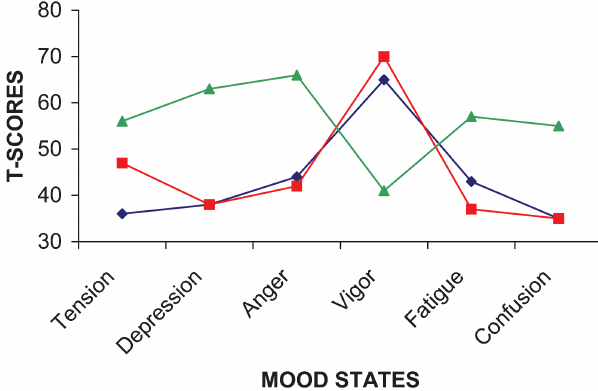
Figure 1 - Comparison of the POMS profile of the physical fitness center members ( ¤ ) with those of elite athletes with signs of overtraining 1 ( m ) and elite athletes who show no signs of overtraining 22 ( &